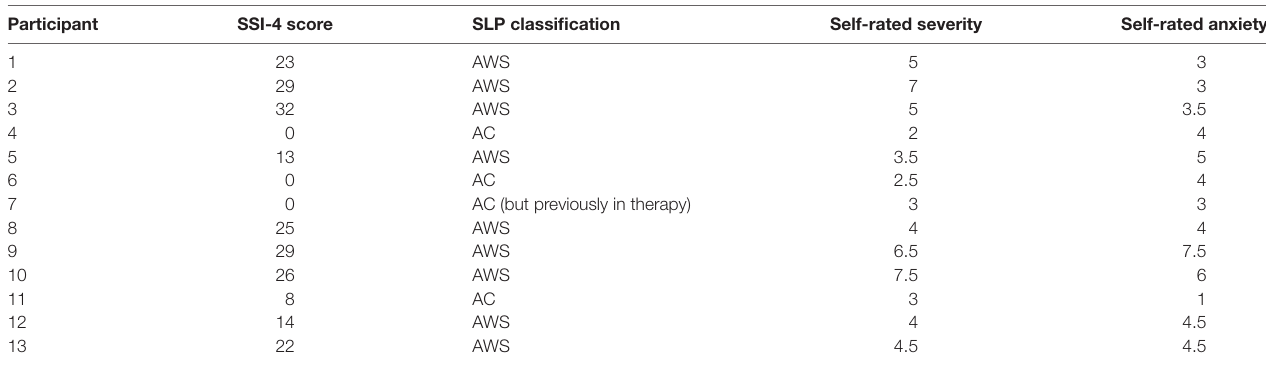
TABLE 1 | Characteristics of self-identified participants with a stutter.